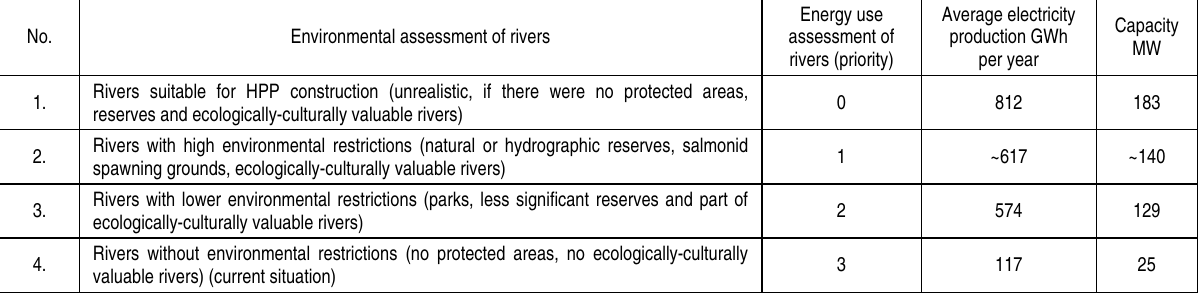
Table 2. Reduction of hydropower potential due to legal restrictions (Punys et al., 2010) No. Environmental assessment of